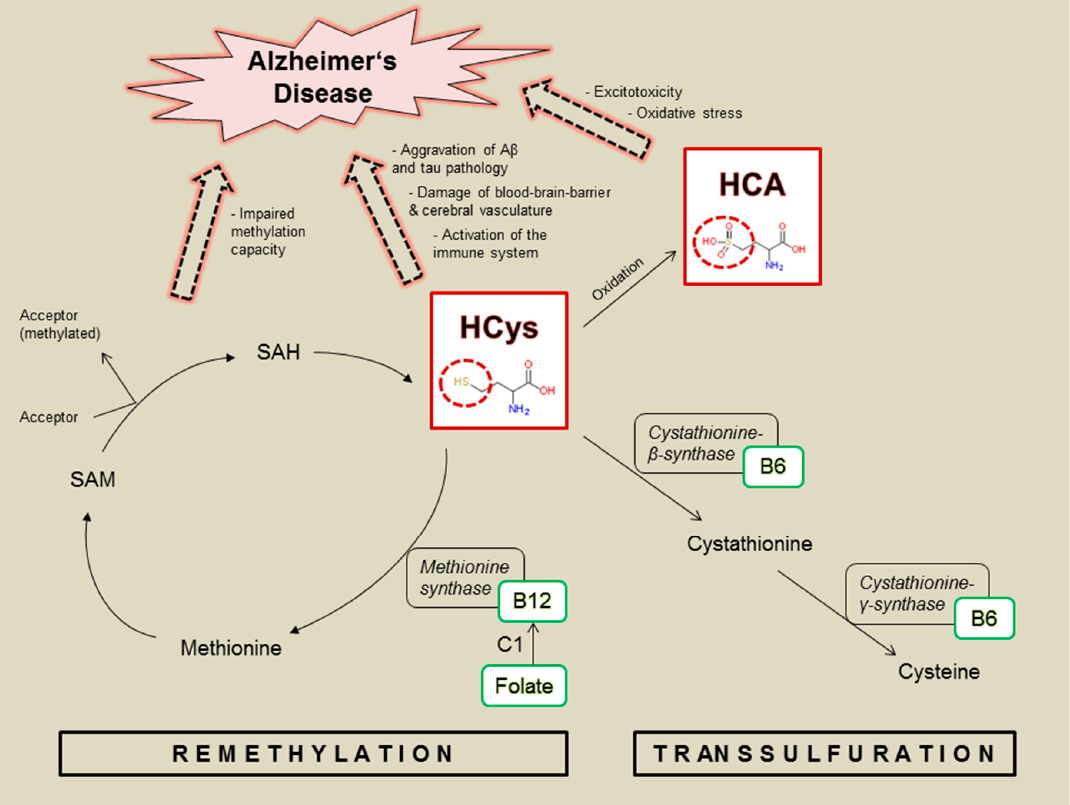
Figure 1. Homocysteine (HCys) and homocysteic acid (HCA): metabolic role and link to Alzheimer’s disease; involved enzymes (black boxes) linked to relevant B-vitamins (green boxes) functioning as coenzymes or methyl donor (C1); SAM = S-Adenosyl-L-methionine; SAH = S-Adenosyl-L- homocysteine.